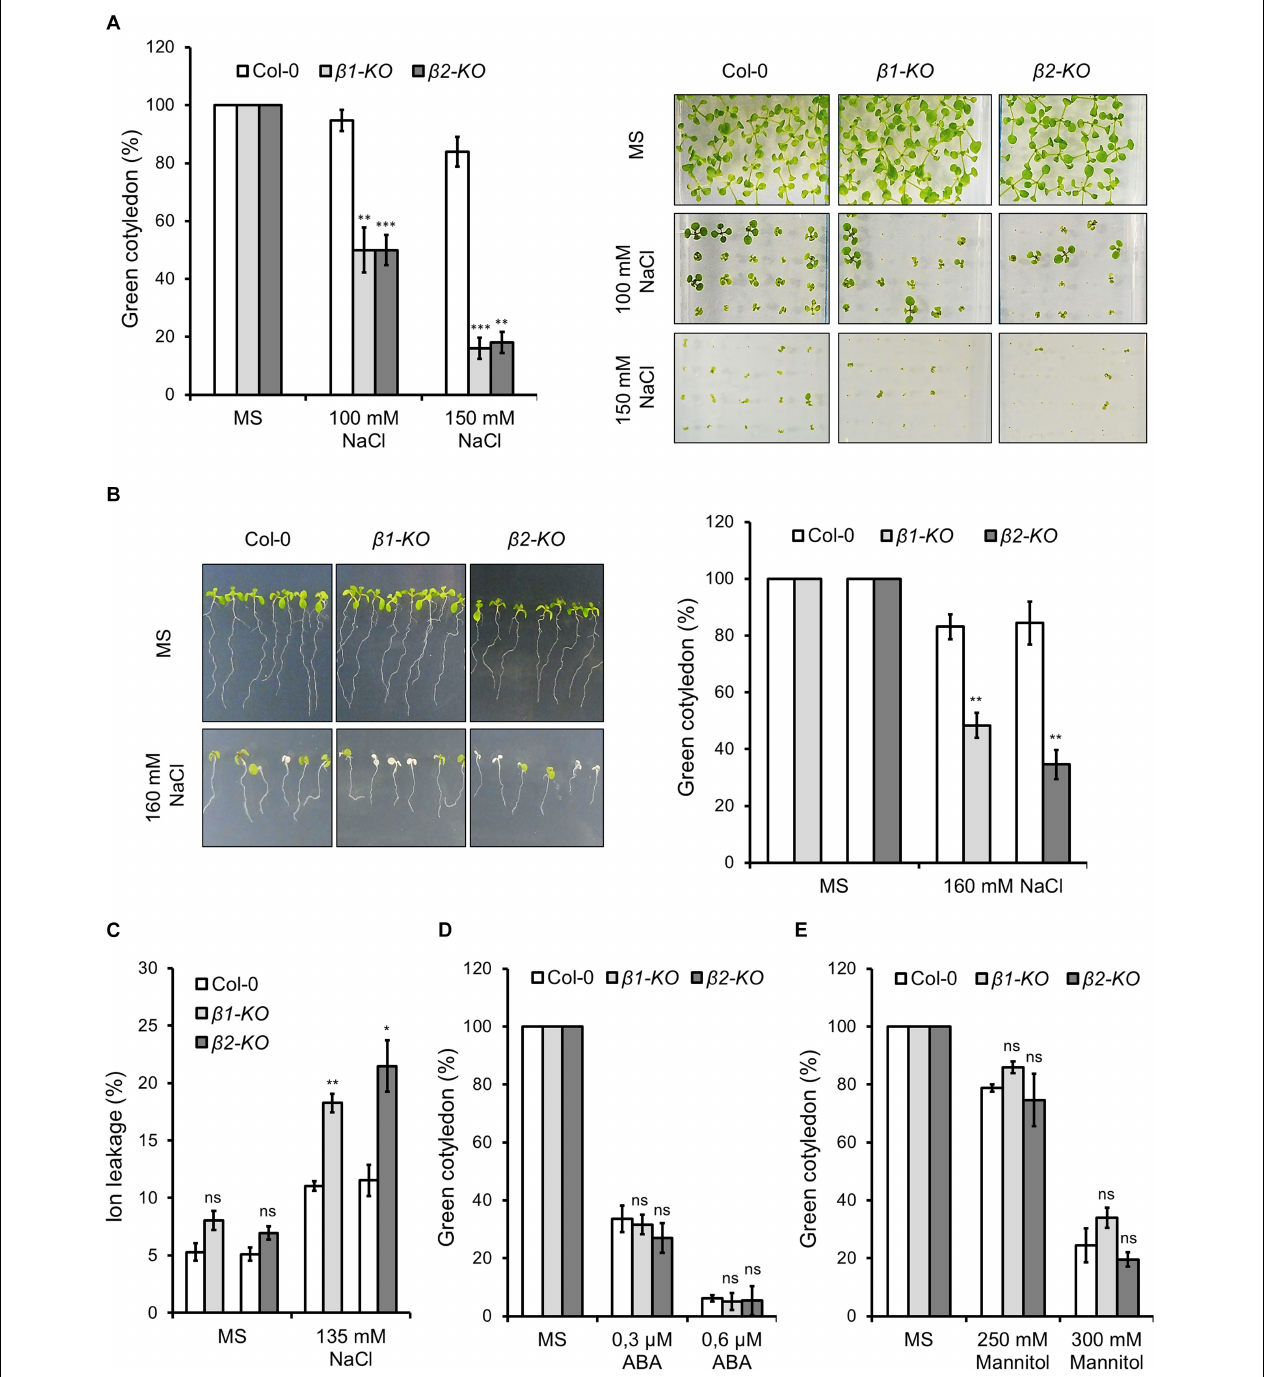
FIGURE 3 | Phenotypic analysis of β 1-cop and β 2-cop mutants exposed to salt (NaCl), mannitol and ABA. (A) Wild type (Col-0) and β 1-cop and β 2-cop seeds were sown on 0.5 × MS as a control and 0.5 × MS supplemented with 100 mM or 150 mM NaCl. Left panel shows the percentage of seedlings with green cotyledons calculated after 12 days and are mean ± s.e.m. ( n = 100) of four independent experiments. Right panel shows an image of a representative experiment. (B) Seeds of wild type (Col-0) and β -COP mutants were sown on MS plates without salt and grown for 4 days before being transferred to MS plates containing 160 mM NaCl. Three days after transplantation, the percentage of seedlings with green cotyledons was calculated and expressed as mean ± s.e.m. ( n = 60) of three independent experiments (right panel). An image of a representative experiment is shown in the left panel. (C) Ion leakage of wild type and β -COP mutants one day after transplanting seedlings to MS plates containing 135 mM NaCl. Data show mean ± s.e.m of three independent experiments. (D,E) Wild type (Col-0) and β 1-cop and β 2-cop seeds were sown on 0.5 × MS or 0.5 × MS supplemented with ABA (D) or mannitol (E) . Data is the percentage of seedlings with green cotyledons calculated after 12 days and are mean ± s.e.m of three independent experiments ( D: n = 60; E: n = 135). Statistical significance: ns, not significant; * p < 0.05; ** p < 0.01; *** p < 0.001.